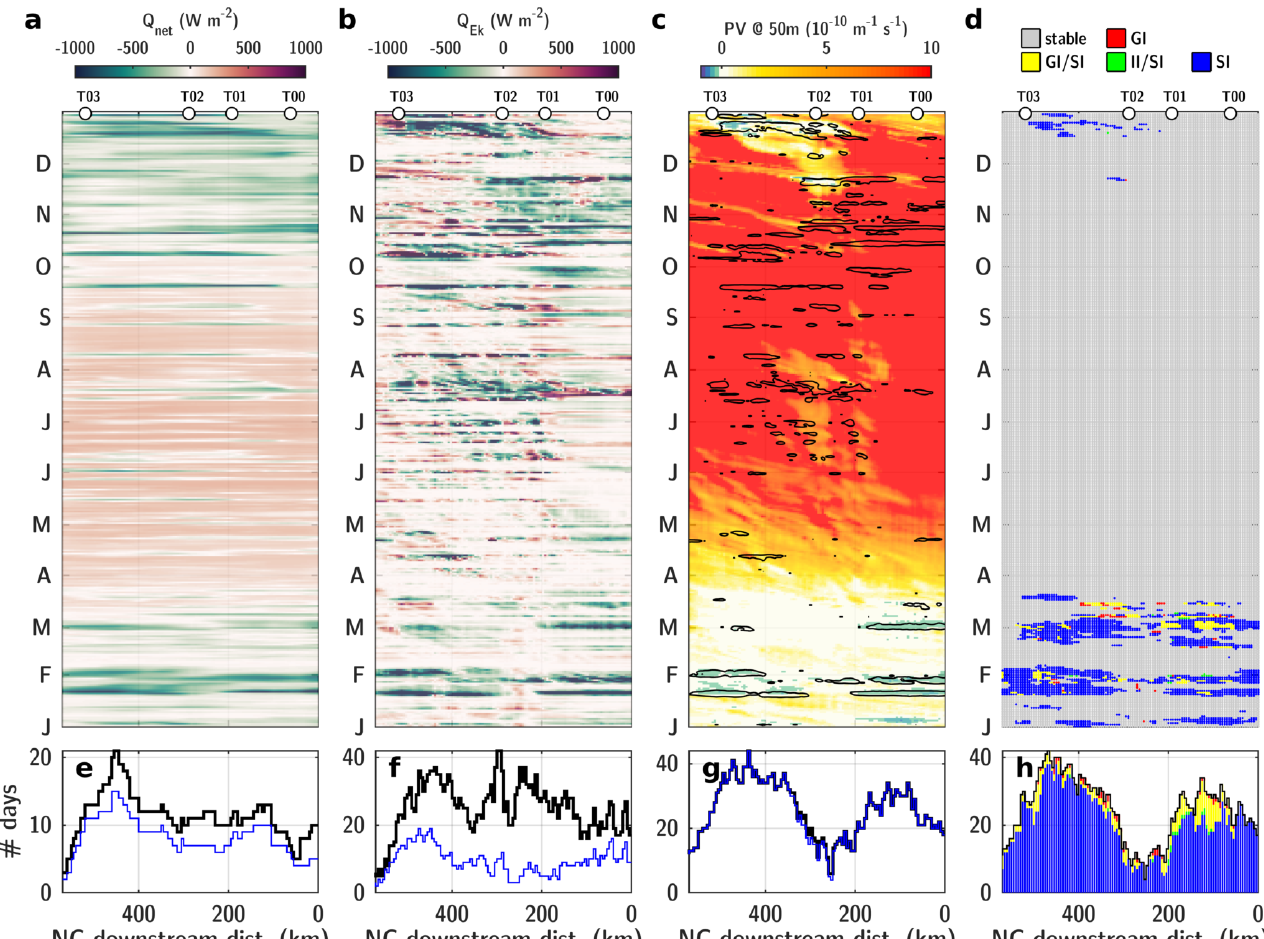
Figure 8. Hovmöller diagram in the SYMPHONIE model along the NC path (trajectory shown in Figure 7d). The signals are averaged in 10 × 10-km bins, typical of the deformation radius. ( a ) net surface heat flux, ( b ) Ekman equivalent heat flux, ( c ) PV at 50m depth with black contours where Q Ek < − 500Wm − 2 , ( d ) instability regimes where color corresponds to at least 25% of a bin area. ( e ) Number of days per year along NC with net surface heat flux below − 500Wm − 2 (annual in black, winter DJFM in blue). ( f ) Same as ( e ) but for Ekman equivalent heat flux. ( g ) Number of days per year with negative PV (annual in black, winter DJFM in blue). ( h ) Number of days per year where different types of instability